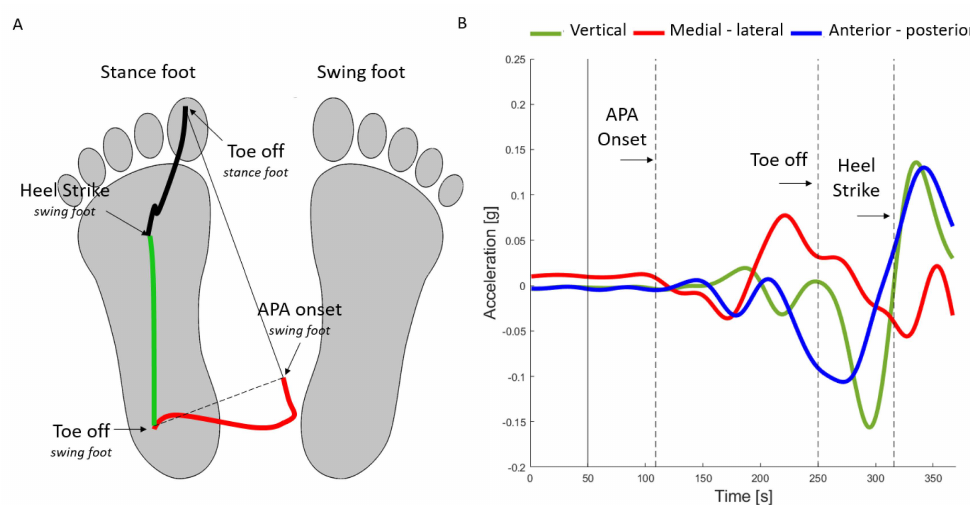
Figure 1. ( A ) COP displacement and ( B ) Acceleration signal during the gait initiation prior to the step in a healthy subject. In the panel A, the COP trace from APA onset to APA end (i.e., toe off) is reported in red and during the swing phase in green. In the panel B the first vertical line represents the auditory cue release and the next 3 vertical lines are the points derived by the algorithm, APA onset, swing leg toe-off and heel